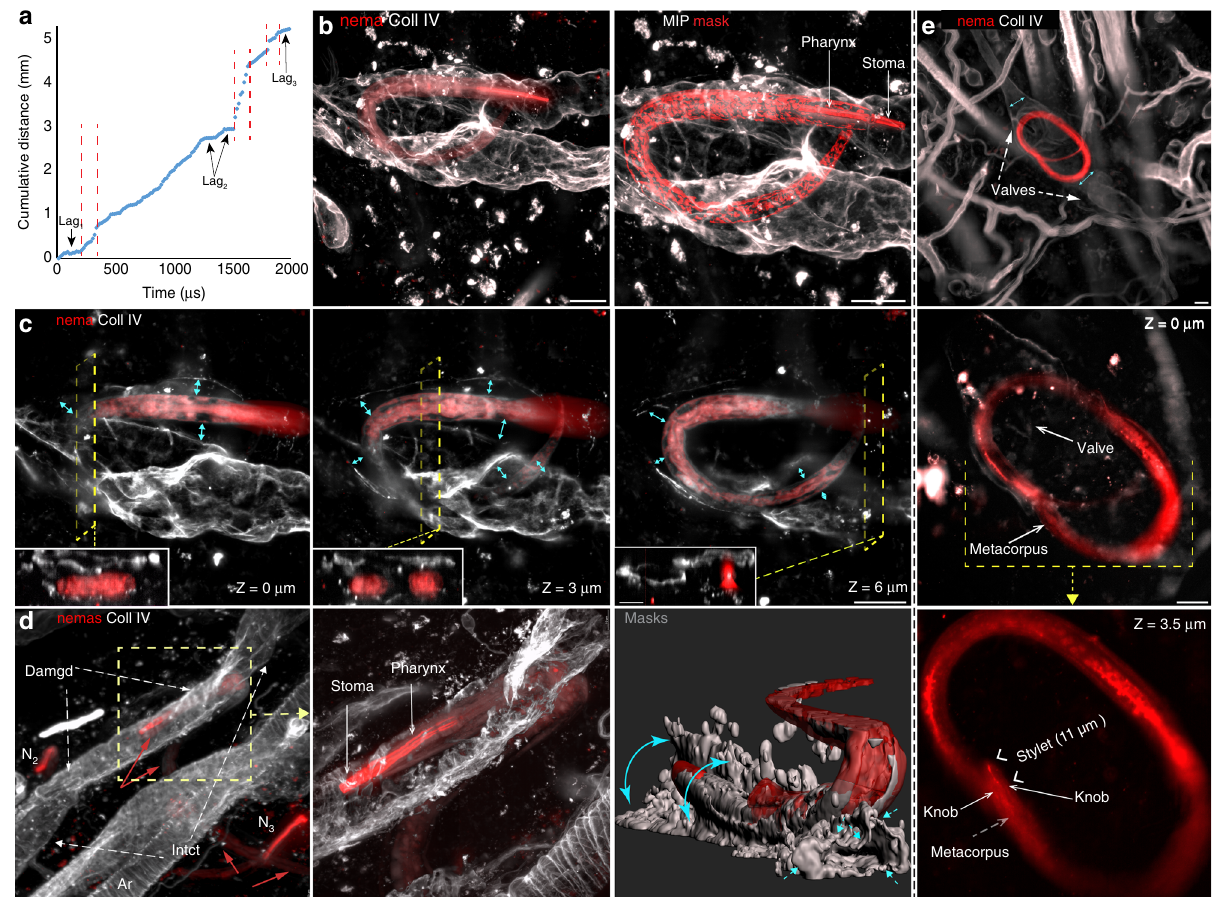
Fig. 5 Soil nematodes migrate through the dermis and enter collecting lymphatics. Confocal images of whole-mounted skin inoculated with TRITC-labeled soil-derived nematodes (nemas) and stained for collagen IV (Coll IV). a Soil-derived nematode displays a discrete pattern of in-dermis migration (analysis performed on a single nematode). Graph shows the speed and unidirectionality of migrating nematode (Supplementary Movies 18 and 19) with three distinct phases: backward – forward movements (lags, no migration), slow, and burst migration ( V fast = 635 μ m/min, arrows). b – d Bacterivore nematodes within a lymphatic collector. b , c A bacterivore nematode located entirely within a collecting lymphatic vessel. b Left, maximum intensity projection (MIP) of the bacterivore with strongly labeled unmodi fi ed tubular stoma and pharynx 62,63 . b Right, MIP of collagen IV and a surface mask over the entire signal range of the nematode. Left panel c , 3.5 µ m optical XY sections show that the nematode shown in ( b ) was enclosed by the basement membrane (BM) wall of the collector. Double arrows are drawn between the lymphatic wall and the nematode. Insets show 2- μ m YZ cross-sections of the stack. d Damaged to lymphatic collector invaded by bacterivore nematode. d Left and d Middle, collector partially invaded by N inv nematode. The BM of the invaded lymphangion had a disorganized composition as compared to the BM in the surrounding segments. N inv , bacterivore that partially invaded lymphatic collector, N 2 and N 3 , two nematodes within interstitium, Ar-artery. d Right, A single intensity surface masks over the entire signal range of the nematode (red) and collagen IV (white). Head of the bacterivore located within the projected lumen of the collecting lymphatic. Lost wall of the lymphatic is marked by double arrows. Arrows point to intact valve trunk afferent to the damaged collector. e Phytoparasitic nematode within the lymphatic collector has weakly stained gastrointestinal tract that begins with the stylet, negatively stained stylet knobs, and the esophageal metacorpus 63 . Sections thickness: Top: 25 µ m, Middle and Bottom: 0.75 µ m. Double arrows point to the wall of the collector. In ( c ) and ( e ), Z indicates the relative distance between optical cross- sections. Source data for the graph shown in ( a ) is provided as a source data fi le. Scale bars: 20 μ m, 10 μ m in ( c ) insets (YZ